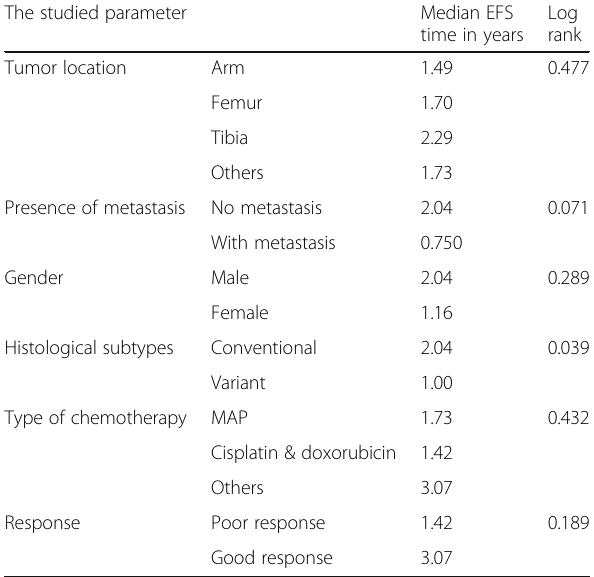
Table 7 Association between different parameters and median EFS rate in osteosarcoma patients treated with cisplatin combinations The studied parameter Median EFS